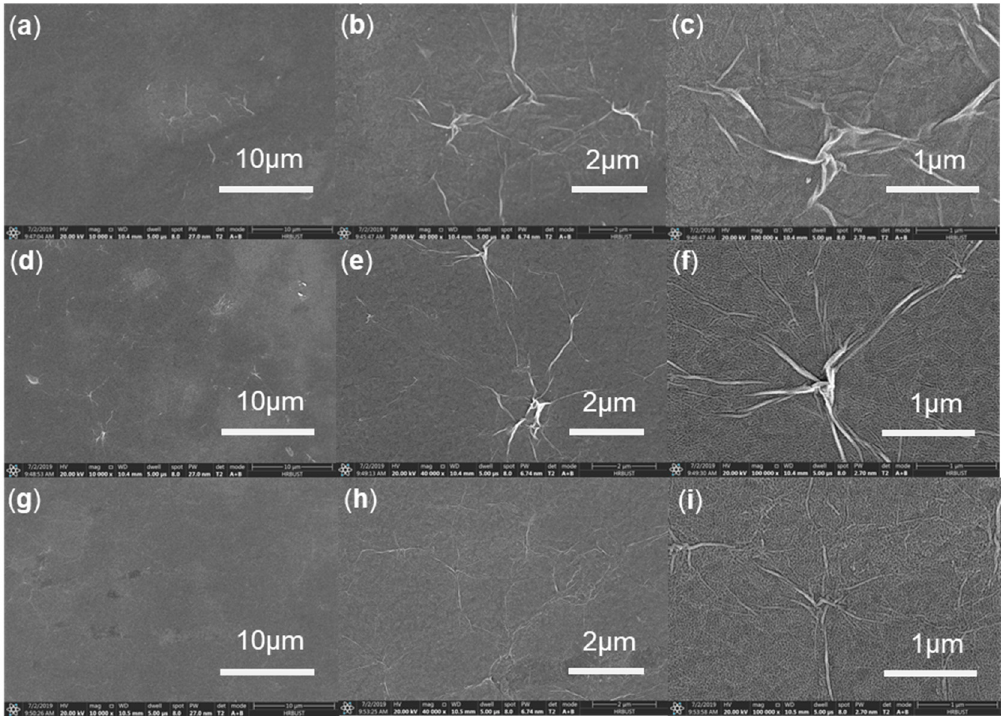
Figure 1. ( a ) Chemical structure of carboxylated chitosan (CS) and graphene oxide (GO) and sandwiched structure of ITO/CS:GO/Ni (right); ( b – d ) the cross-sectional profiles of CS:GO nanocomposite films coated on the ITO/glass substrates with a mass ratio of the chemical component CS:GO 2:1, 5:1, and 10:1, respectively.